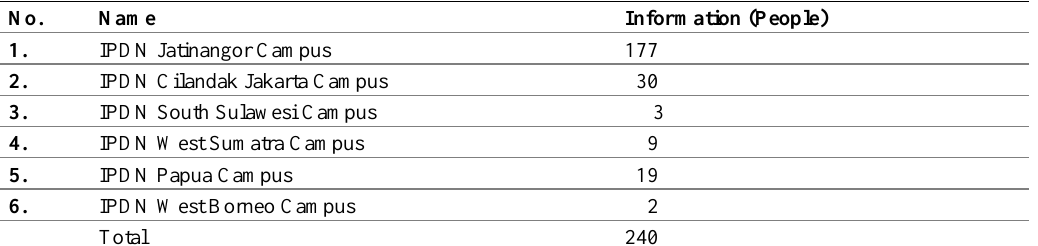
Table 1: The number of civil servants who have not completed the SKP Quality Assessment and Behavior Assessment in the Sikerja application in 2019 No.